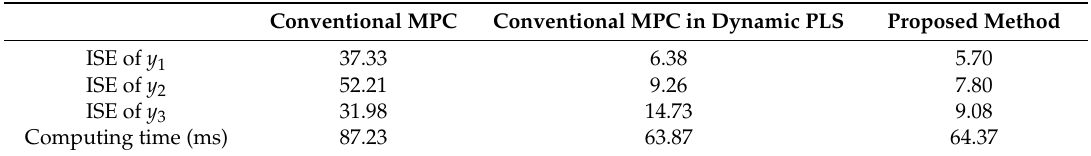
Table 2. Integral of squared error (ISE) and computing time of three methods.